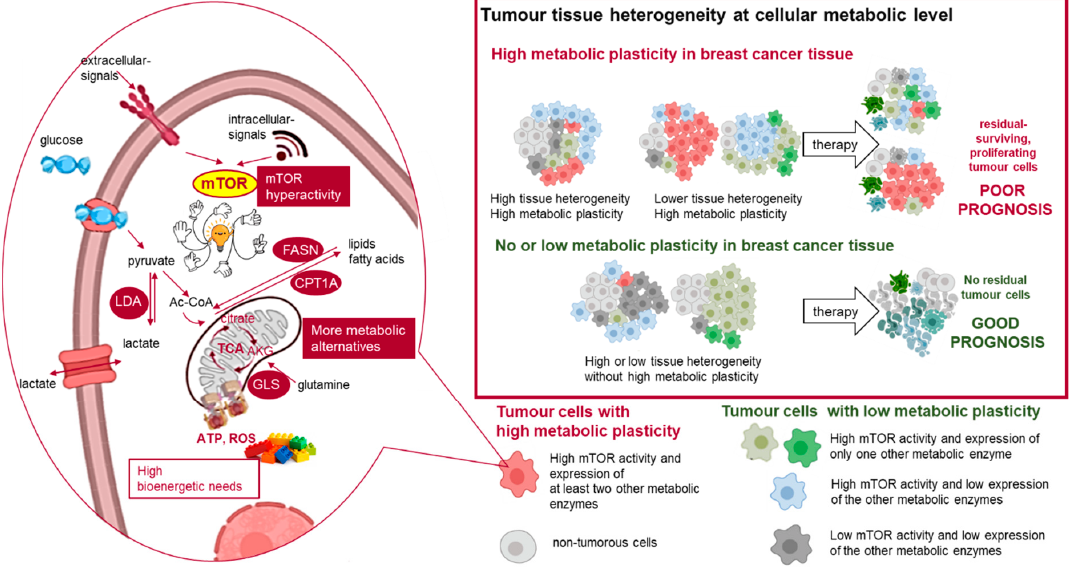
Figure 9. Metabolic adaptation in breast cancer tissues and their impact on therapy response. The individual differences in cellular metabolic phenotype contribute to tissue heterogeneity in the tissue microenvironment. The schematic figure summarises the examined elements of metabolic adaption and the detected different metabolic subtypes in the studied breast cancer cells (cells with high metabolic plasticity: high mTOR activity and high expression of at least two other studied metabolic enzymes; cells with no or low metabolic plasticity: low mTOR activity or high mTOR activity and high expression of only one studied metabolic enzyme). LDHA (lactate dehydrogenase A) is involved in glycolysis, GLS (glutaminase) is involved in glutaminolysis, and FASN (fatty acid synthase) and CPT1A (carnitine palmitoyltransferase 1A) are involved in lipid